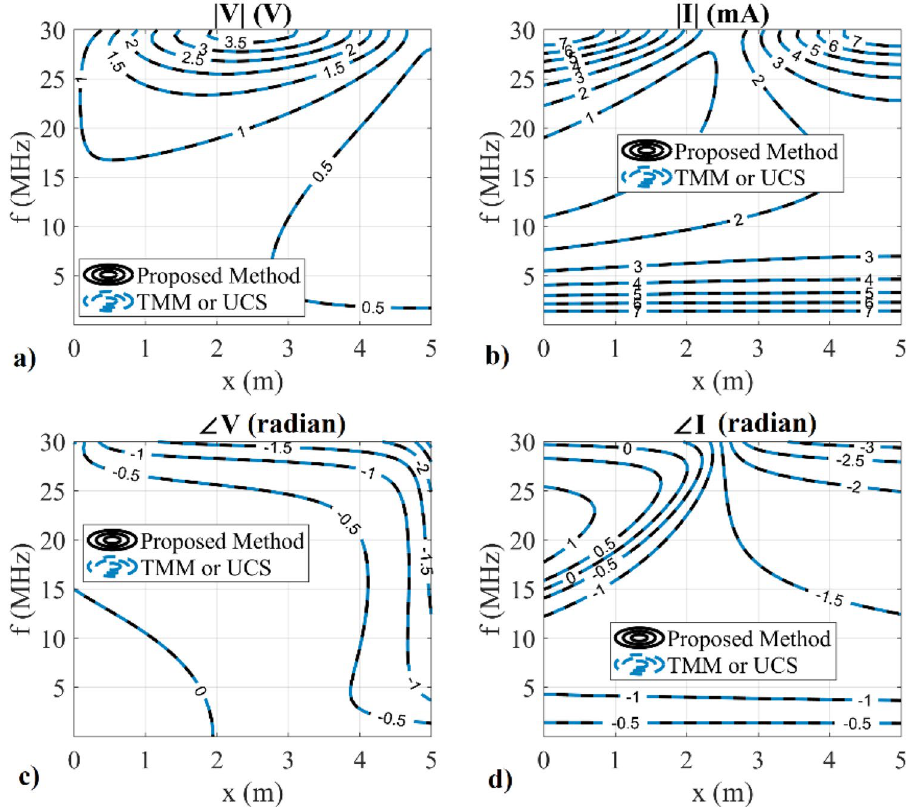
Figure 2. The calculated V ( x ) and I ( x ) of a catenary TL using the proposed and TMM, UCS techniques; ( a ) magnitude of V , ( b ) magnitude of I , ( c ) phase of V , ( d ) phase of I